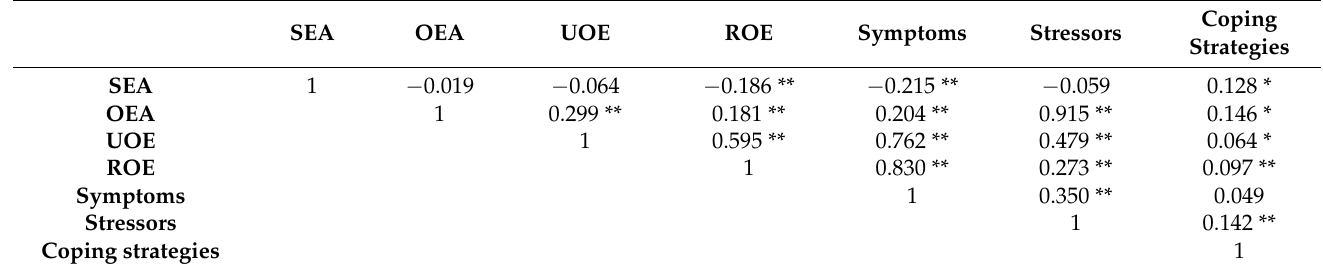
Table 3. Bivariate correlations among EI and academic stress categories for males.